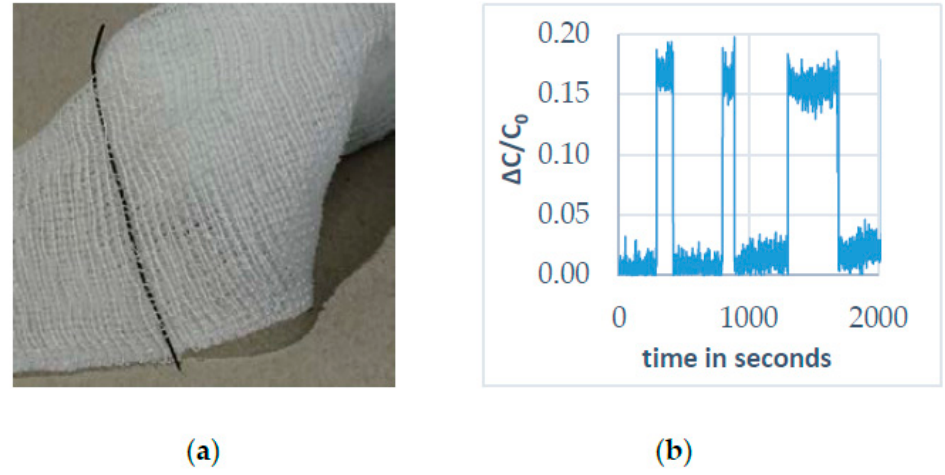
Figure 2. Capacitive sensor elements made by the use of CNT and gelatin/SBR-Insulation show ( a ) a suitable size for the integration into textiles and ( b ) a good signal change under pressure